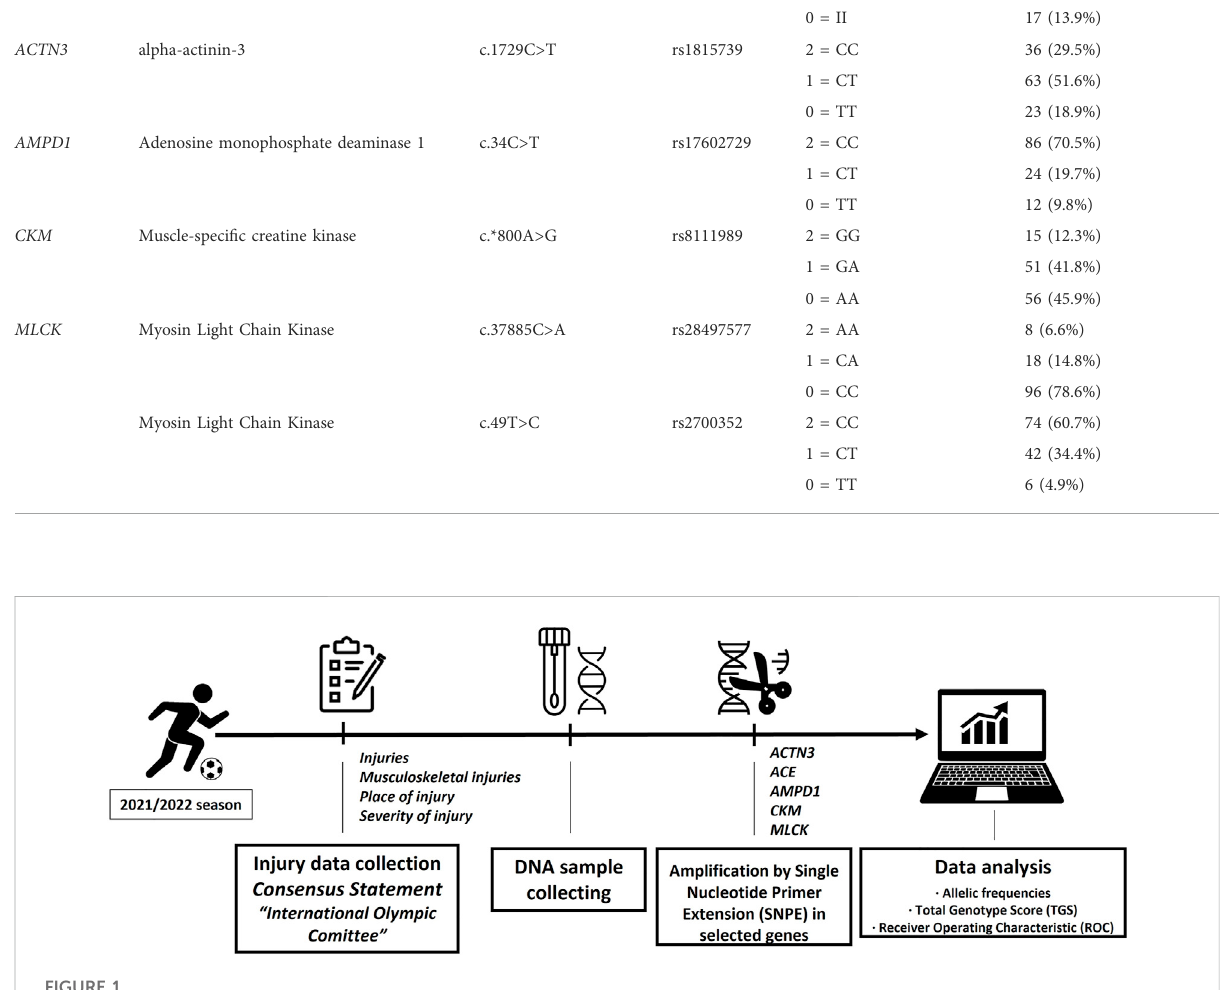
FIGURE 1 Experimental